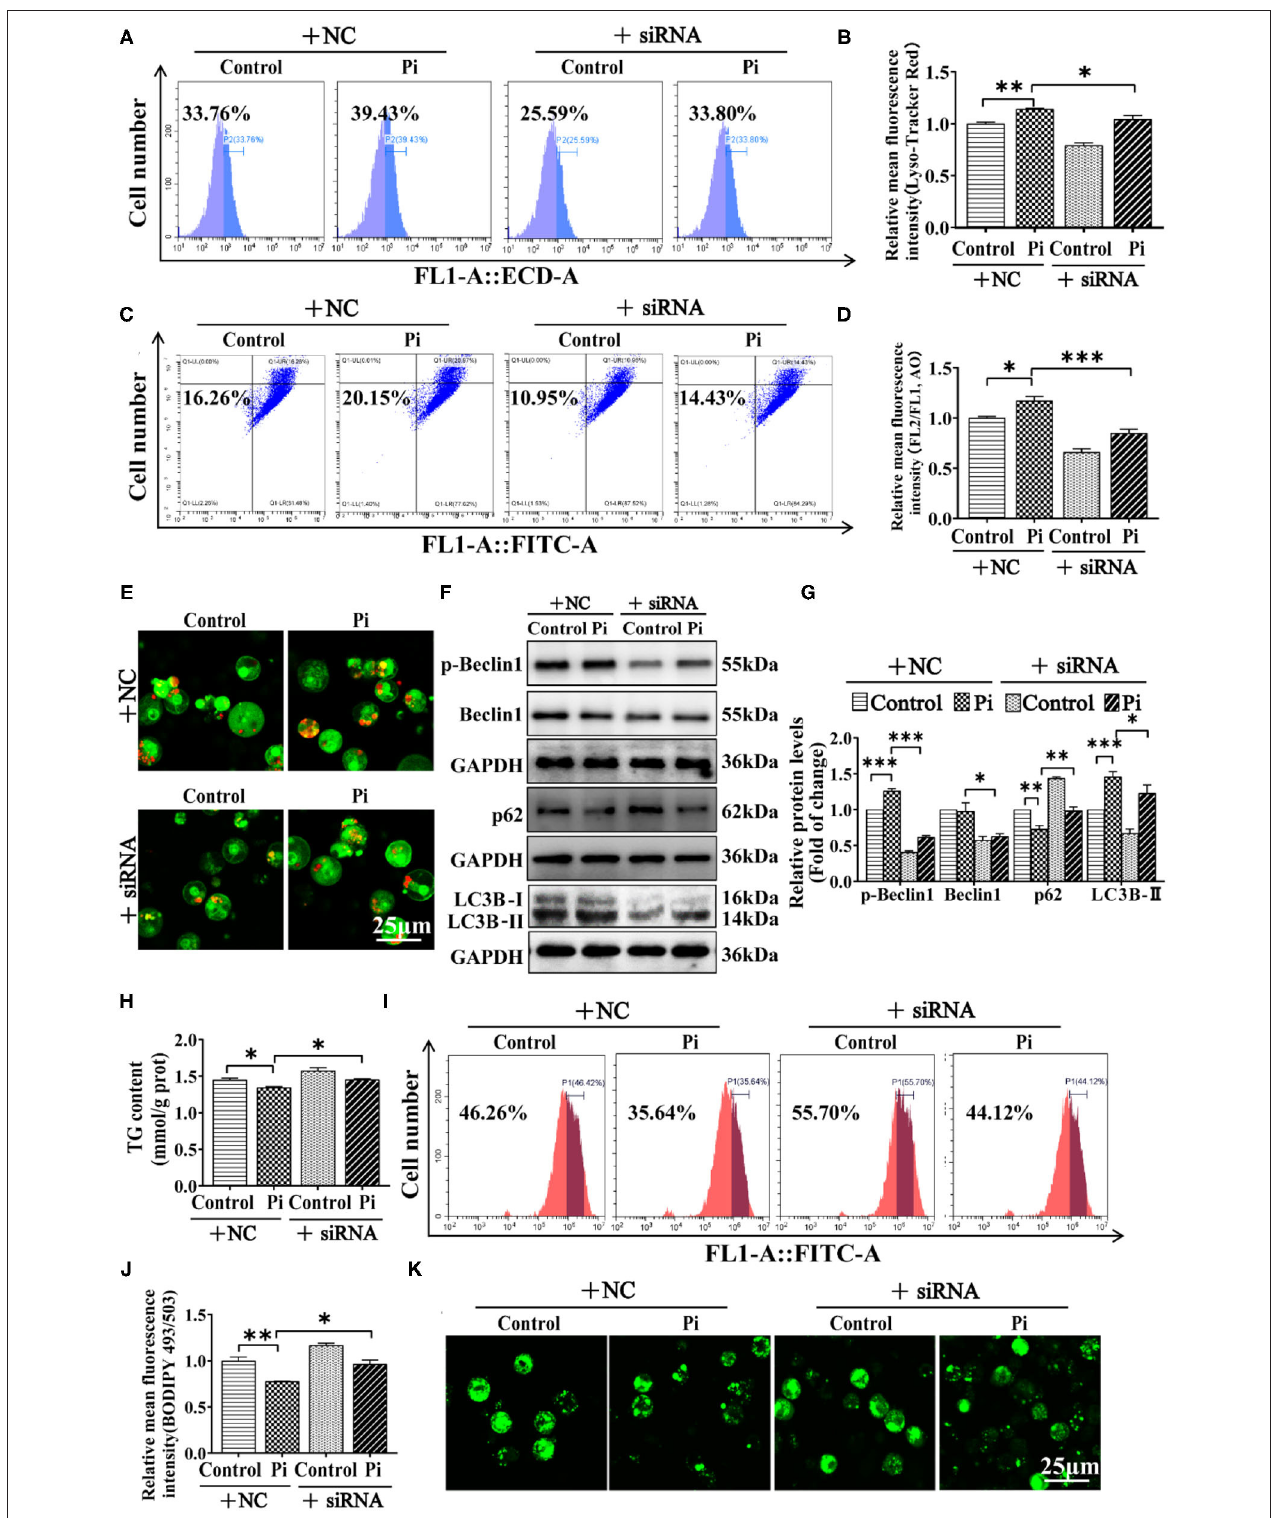
FIGURE 8 | AMPK is required for Beclin1 phosphorylation in phosphorus-induced lipophagy in tilapia hepatocytes. Tilapia hepatocytes were incubated with Pi and AMPK α 1-knockdown experiment for 48h in L-15 medium. (A) The presence of Lyso-Tracker Red-stained autolysosomes was demonstrated by the flow